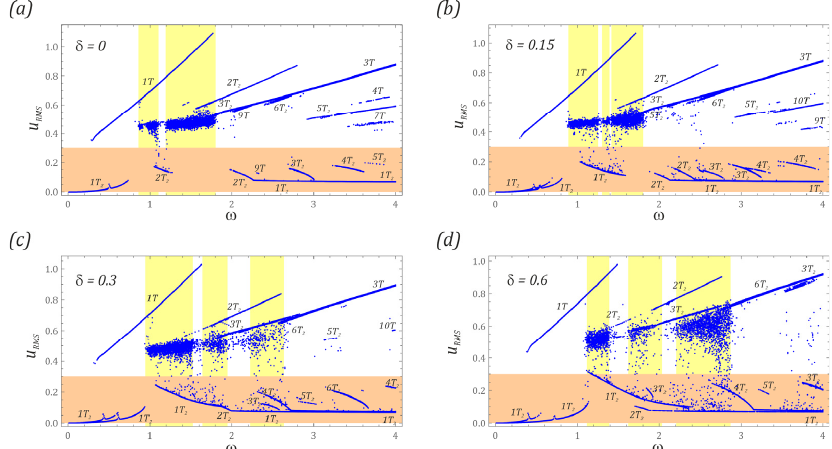
Figure 5. Diagrams of the rms values of voltage induced on piezoelectric electrodes for p = 0.183 and randomly selected initial conditions: ( a ) δ = 0, ( b ) δ = 0.15, ( c ) δ = 0.3, ( d ) δ = 0.6, 𝜅 = 0.5. The branches of broadly distributed points correspond to non-regular (chaotic) solutions. The corresponding frequency bands are marked in yellow. The bright orange color stripe denotes the region of low-energy solutions for the resonator motion located in a single potential well. The response periods nT are with respect to the excitation period T . For n = 1, the response frequency (period) is the same as the excitation frequency. For n > 1 the solutions represented are the small and large orbit solutions with subharmonic nature.